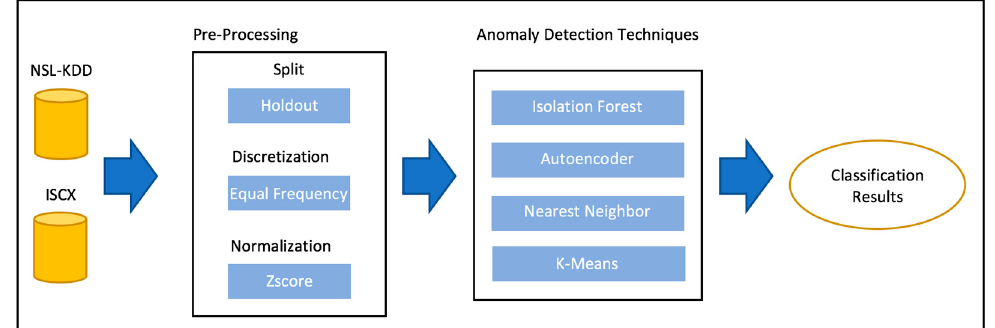
Figure 1. Anomaly detection